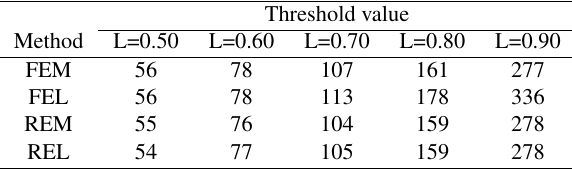
Table 5. Block design for DAP-TR (threshold is block).